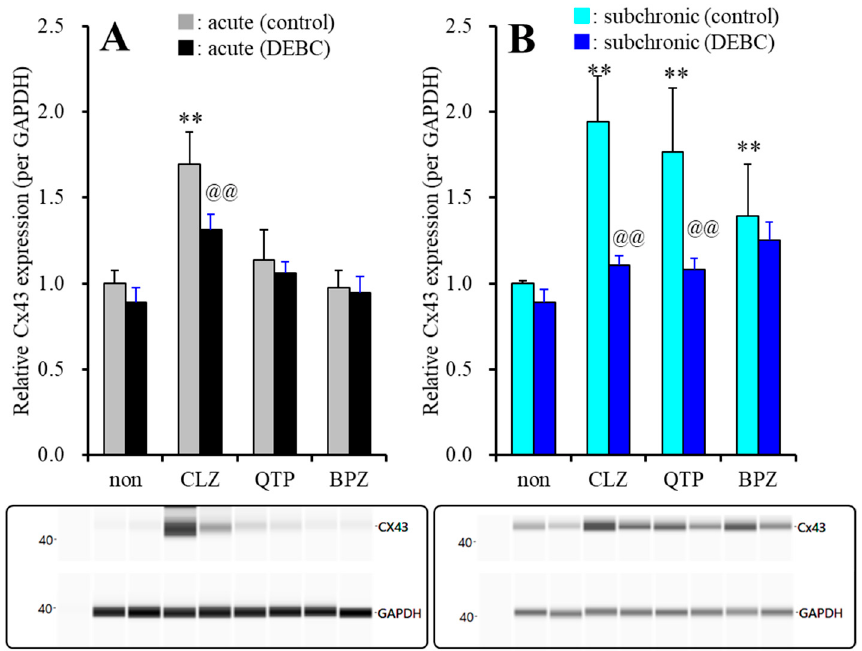
Figure 7. Interaction between acute administration of therapeutic-relevant concentration of antipsychotics and Akt inhibitor (DEBC) on Cx43 protein expression in the astroglial plasma membrane fraction, after subchronic administration of therapeutic-relevant concentration of VPA (500 μ M) ( A ). Interaction between subchronic administration of therapeutic-relevant concentration of antipsychotics and DEBC on Cx43 protein expression in the astroglial plasma membrane fraction, after subchronic administration of therapeutic-relevant concentration of VPA ( B ). Lower panels indicate their pseudo-gel images, using capillary immunoblotting. Ordinate: mean ± SD ( n = 6) of the relative protein level of Cx43 (per GAPDH). Effects of antipsychotics and Akt inhibitor (DEBC: 10 μ M) on Cx43 expression in the plasma membrane fraction of the primary cultured astrocytes were analyzed by MANOVA with Tukey’s post hoc test (** p < 0.01 vs. non, @@ p < 0.01 vs. control).